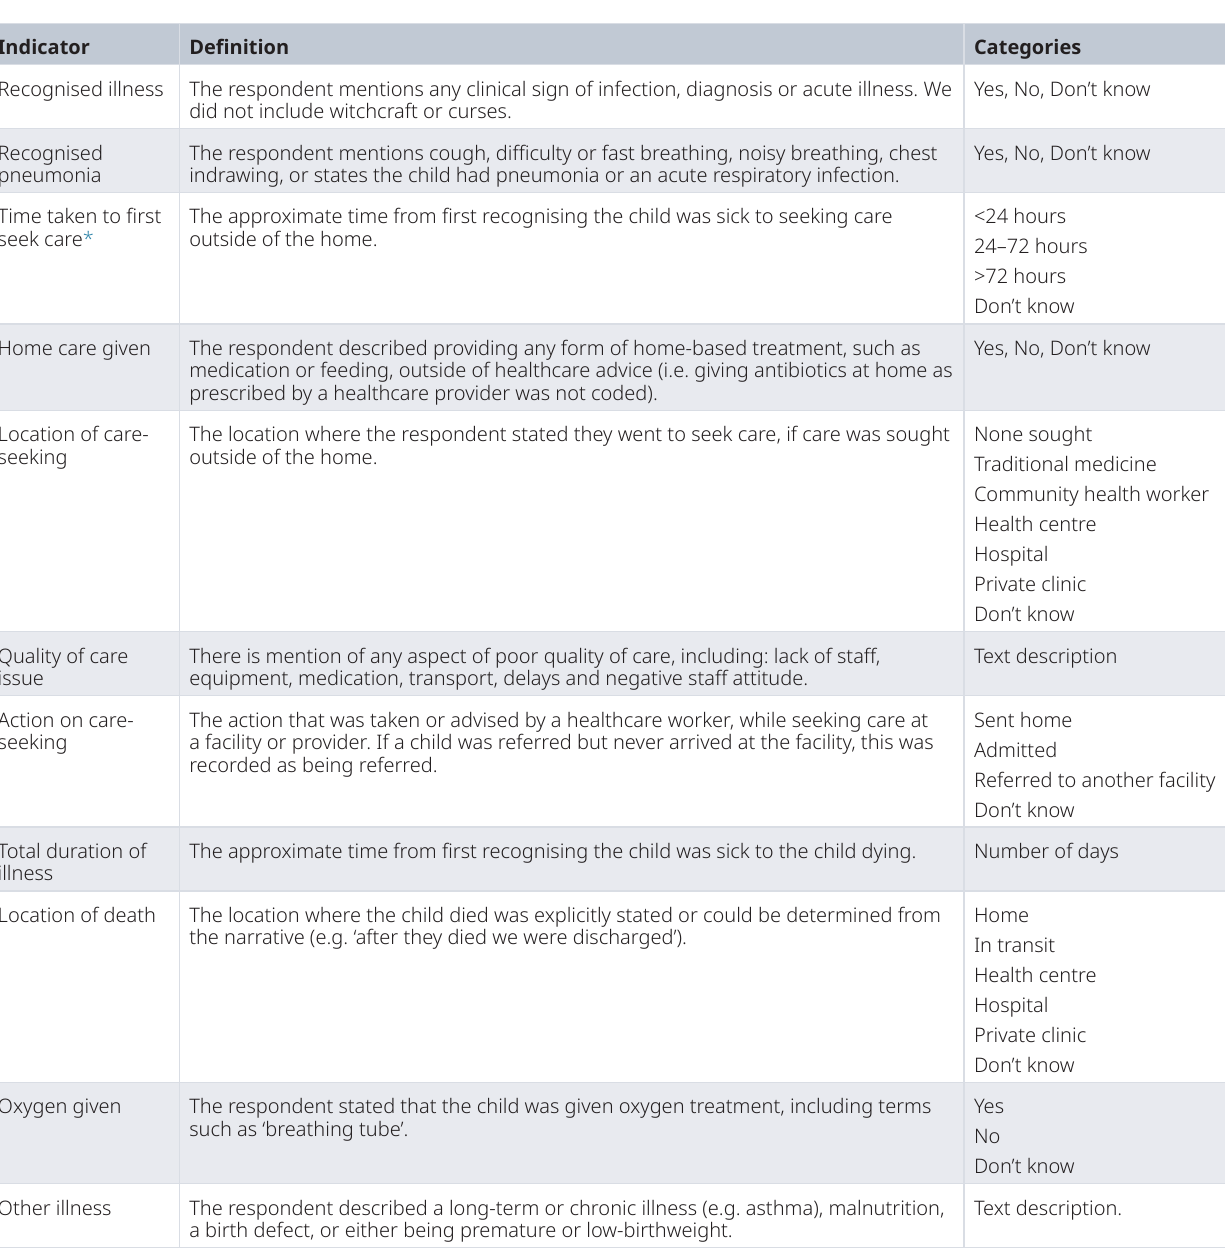
Table 1. List of indicator definitions extracted from open